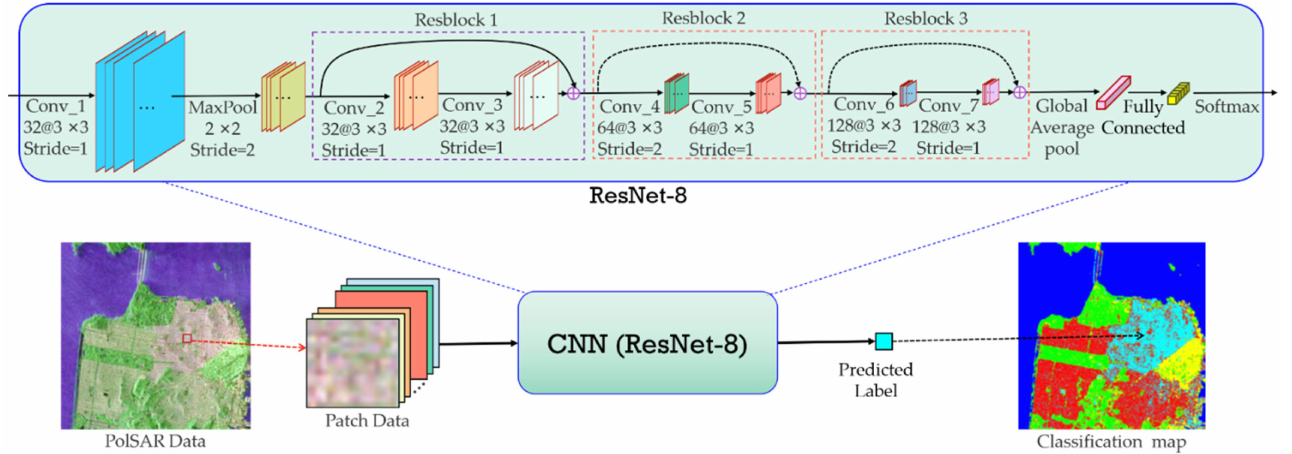
Figure 3. Architecture of the employed CNN and its application in PolSAR image